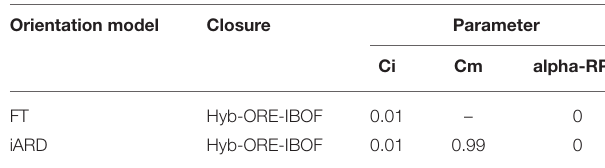
TABLE 1 | Simulation trials for the evaluation of orientation models and closure